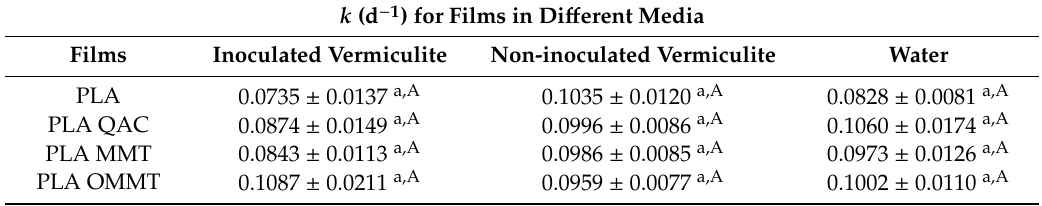
Figure 4. Reduction in molecular weight as a function of time for PLA, PLA QAC, PLA MMT and PLA OMMT films in ( a ) inoculated vermiculite ( b ) non-inoculated vermiculite and ( c ) water media. Values indicated as (cid:70) were considered as outliers and hence not used for fitting. Fitting of the first order equation M n / M no = e ( − kt ) , where M no is the initial M n , k is the rate constant and t is the time. Table 2. Rate constant k (d − 1 ) for PLA, PLA QAC, PLA MMT and PLA OMMT and exposed to di ff erent